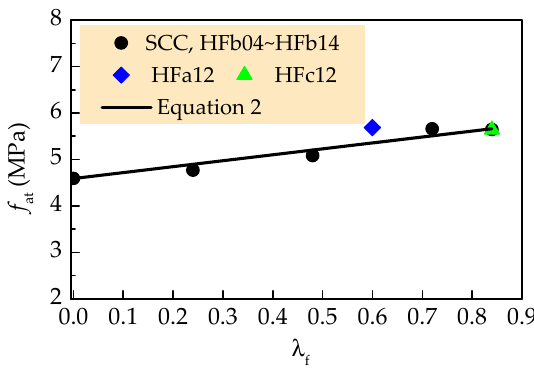
Figure 8. Axial tensile strength as a function of the fiber content .